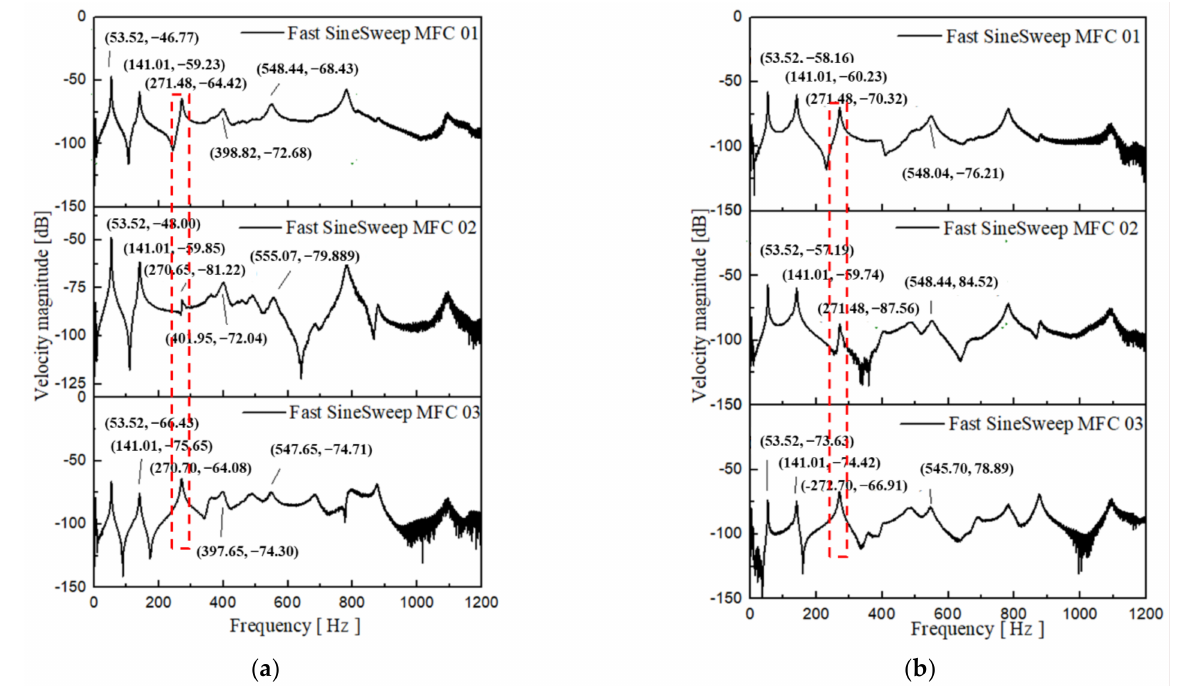
Figure 7. MFC fast sine sweep signal excitation: ( a ) Node 127; ( b ) Node 3.